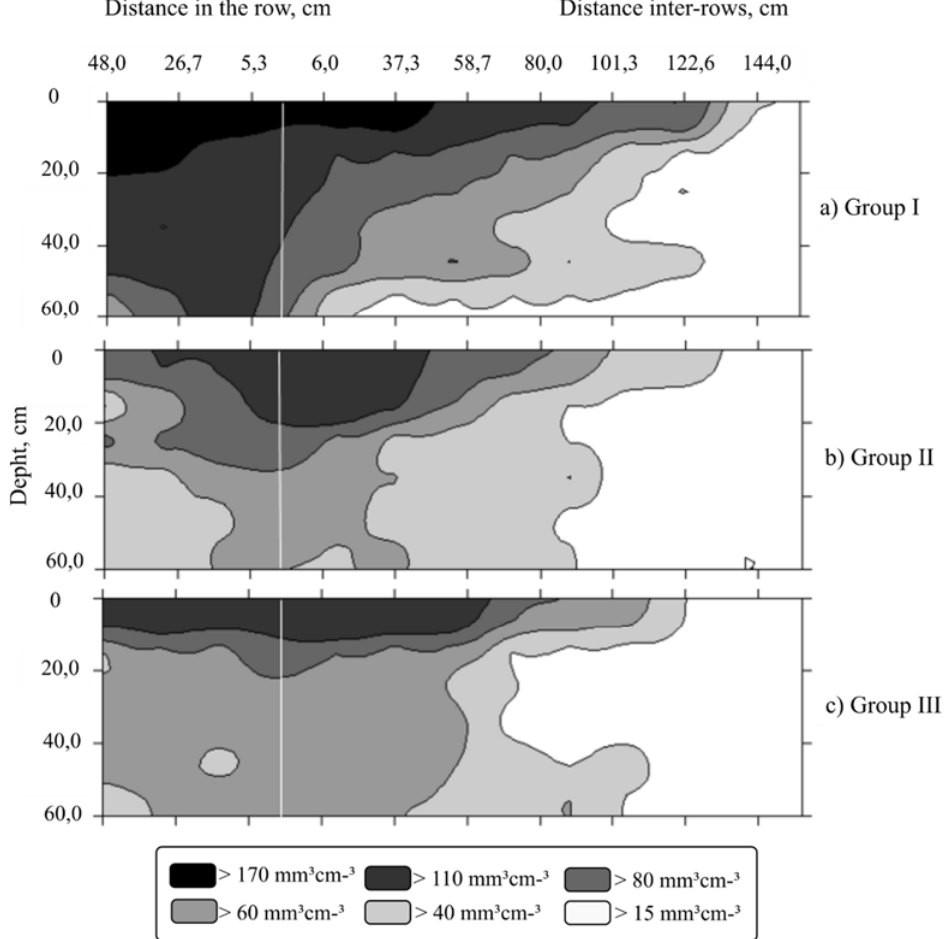
Figure 3. Spatial distribution map of roots in the soil profile for root volume per soil volume, based on the clustering of six C. canephora genotypes at three distances in the planting row (16, 32 and 48 cm) and nine distances in inter-row planting (16, 32, 48, 64, 80, 96, 112, 128, 144 cm). Both distances were measured from the stem of the plant and six depths from the ground (0–10, 10–20, 20–30, 30–40, 40–50 and 50–60 cm) at each distance. The transverse white line refers the location of the plant. ( a ) Group I—AD1, Valcir P and Peneirão genotypes; ( b ) Group II—A1 and P2 genotypes and ( c ) Group III—Z21 genotype.